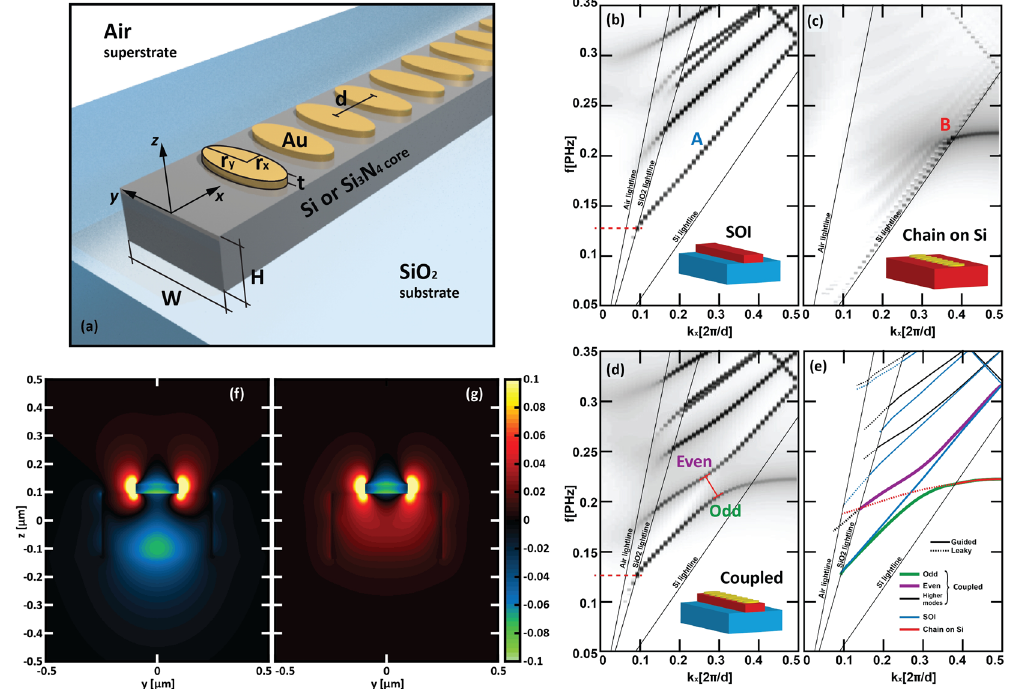
Figure 1. ( a ) Sketch of the proposed coupled system. ( b – e ) FDTD calculated TE band structures of a: ( b ) standard SOI waveguide; ( c ) infinite-long MNP chain placed on a semi-infinite Si substrate; ( d ) full coupled structure. ( e ) Hand-made tracing of the curve superposition. ( f , g ) Self-normalized y -component of the Electric field calculated on the coupled structure for λ = 1.450 μ m ( f = 0.207 PHz). In particular, the figure depicts the ( f ) even and the ( g ) odd supermode, calculated when ( f ) k x = 0.2 2 π /d and ( g ) k x = 0.3 2 π /d ,